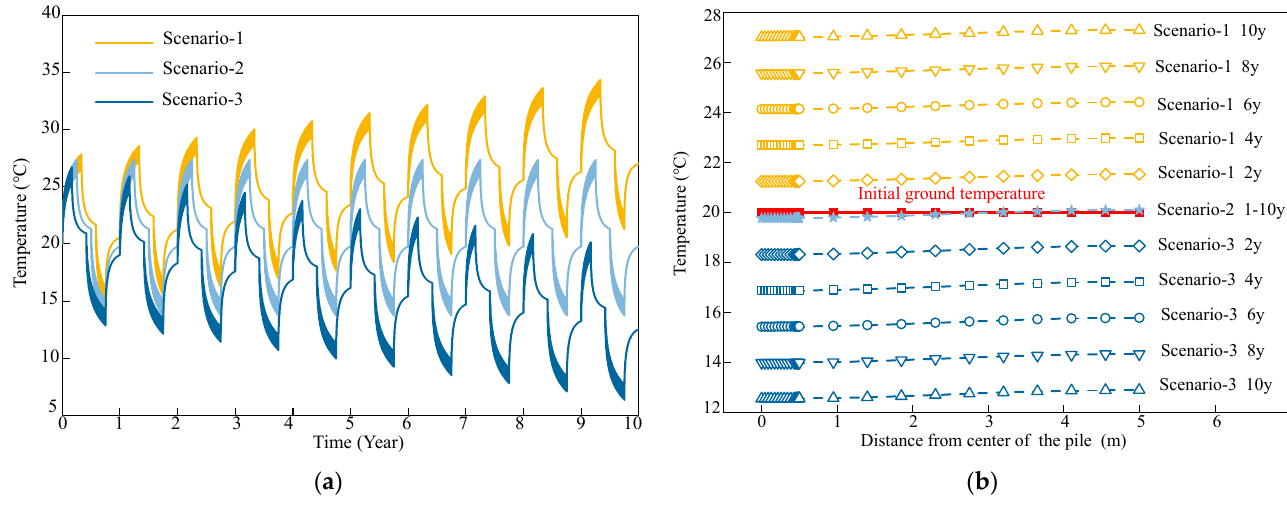
Figure 10. Temperature of pile–soil contact surface and Ground temperature recovery at different years under different scenarios. ( a ) Temperature of pile–soil contact surface. ( b ) Ground temperature recovery at different years.